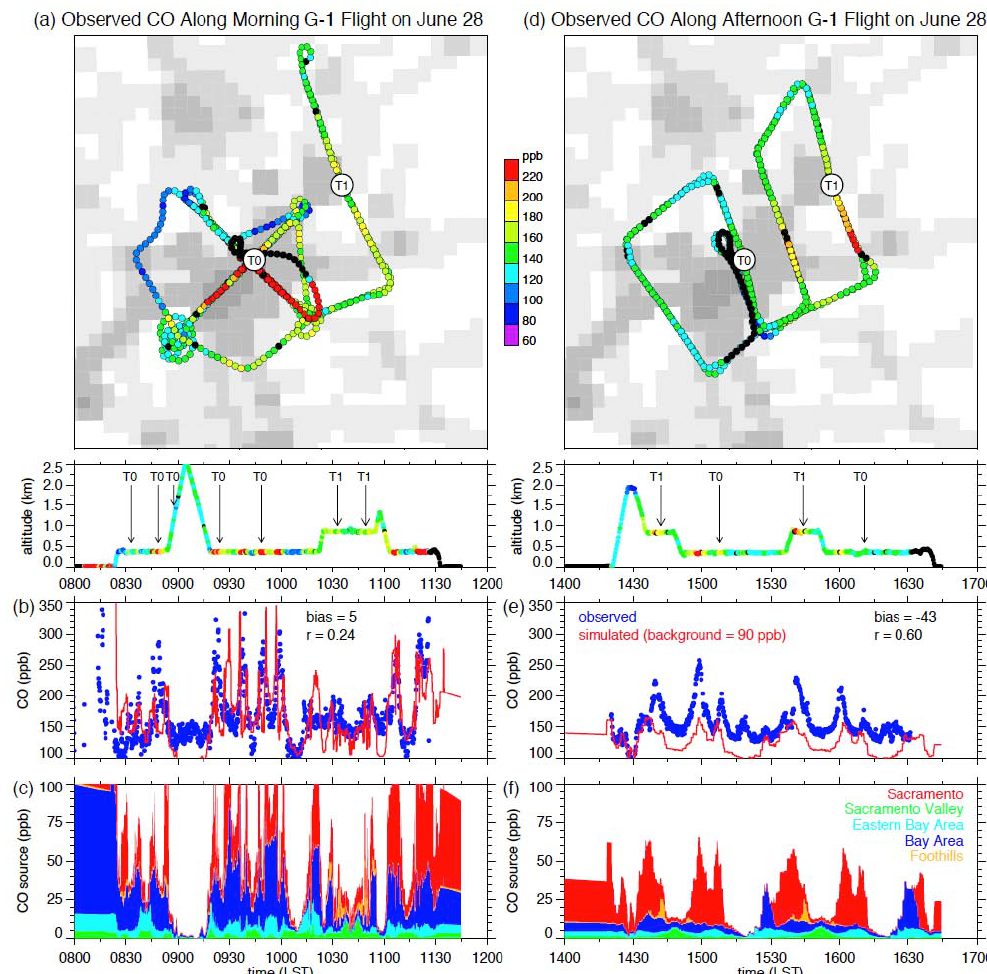
Fig. 11. (a) Spatial distribution of observed CO along the G-1 flight path during the morning of 28 June (b) time series of observed and simulated CO, and (c) simulated CO originating from various source regions. Figures (d) , (e) , and (f) are the same as (a) , (b) , and (c) , except for the afternoon of 28 June. Gray shading in (a) and (d) denotes emission rate of CO from the CARB inventory reapportioned to the WRF grid and black dots denote missing